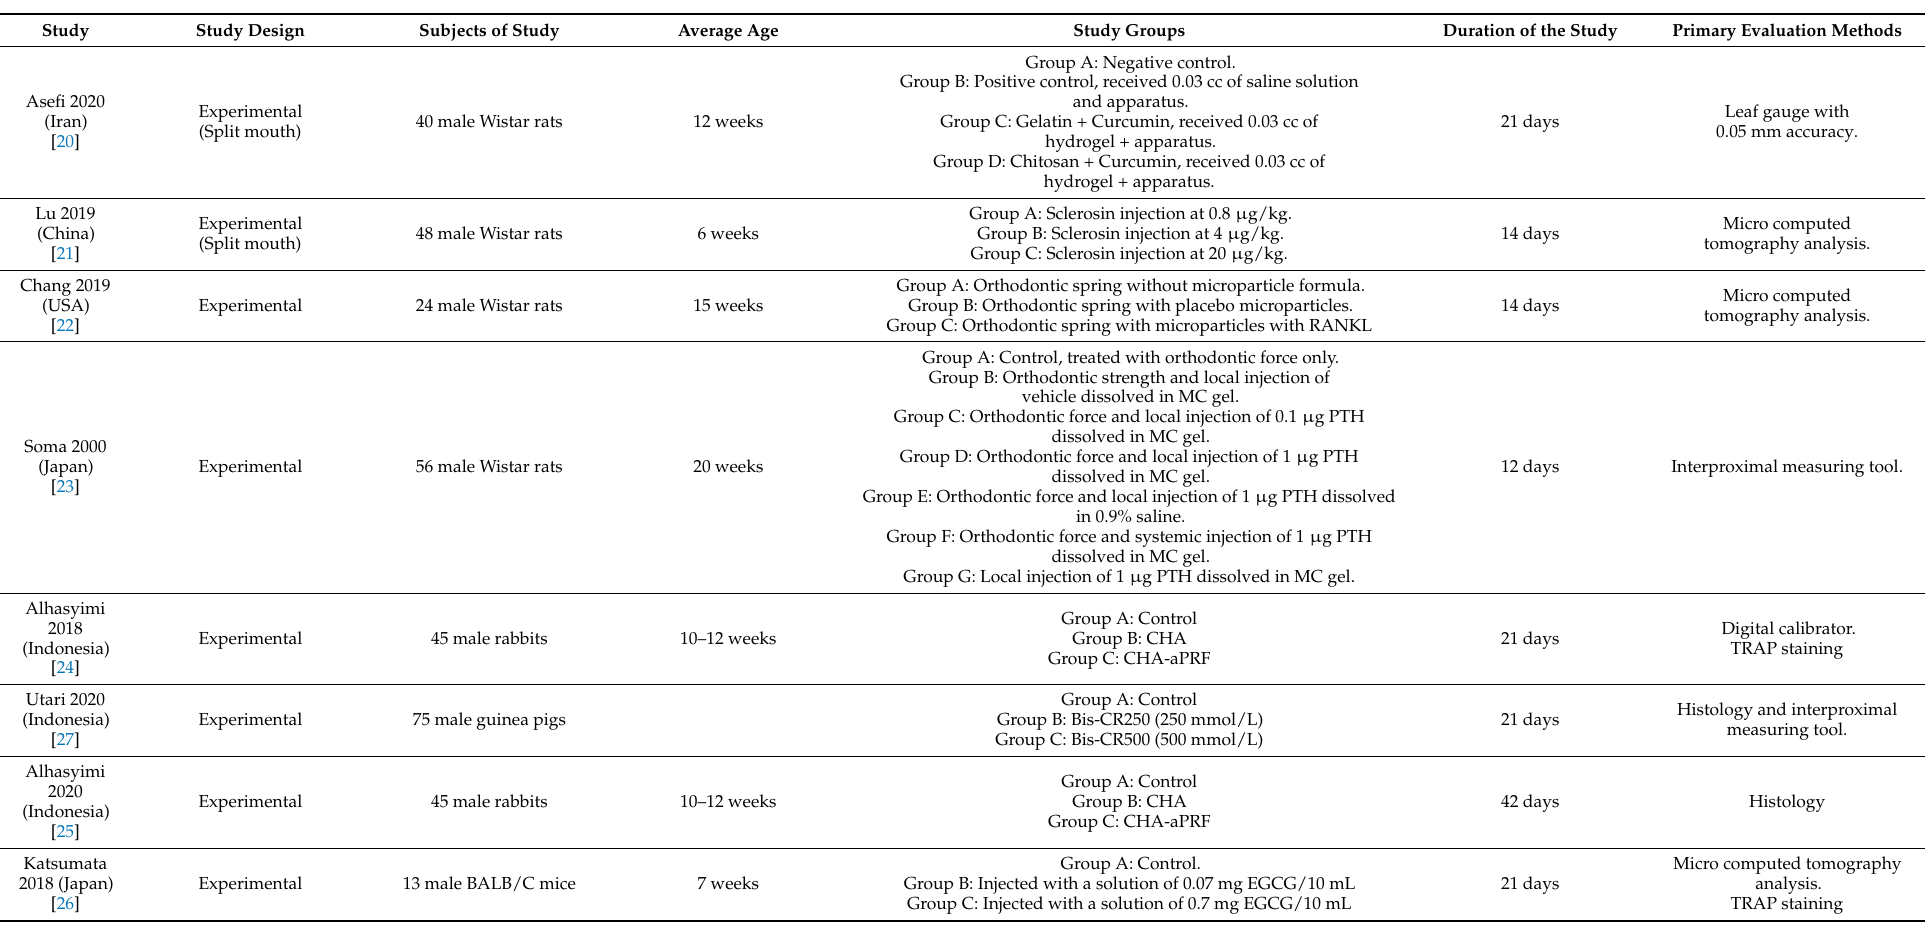
Table 1. General characteristics of the included